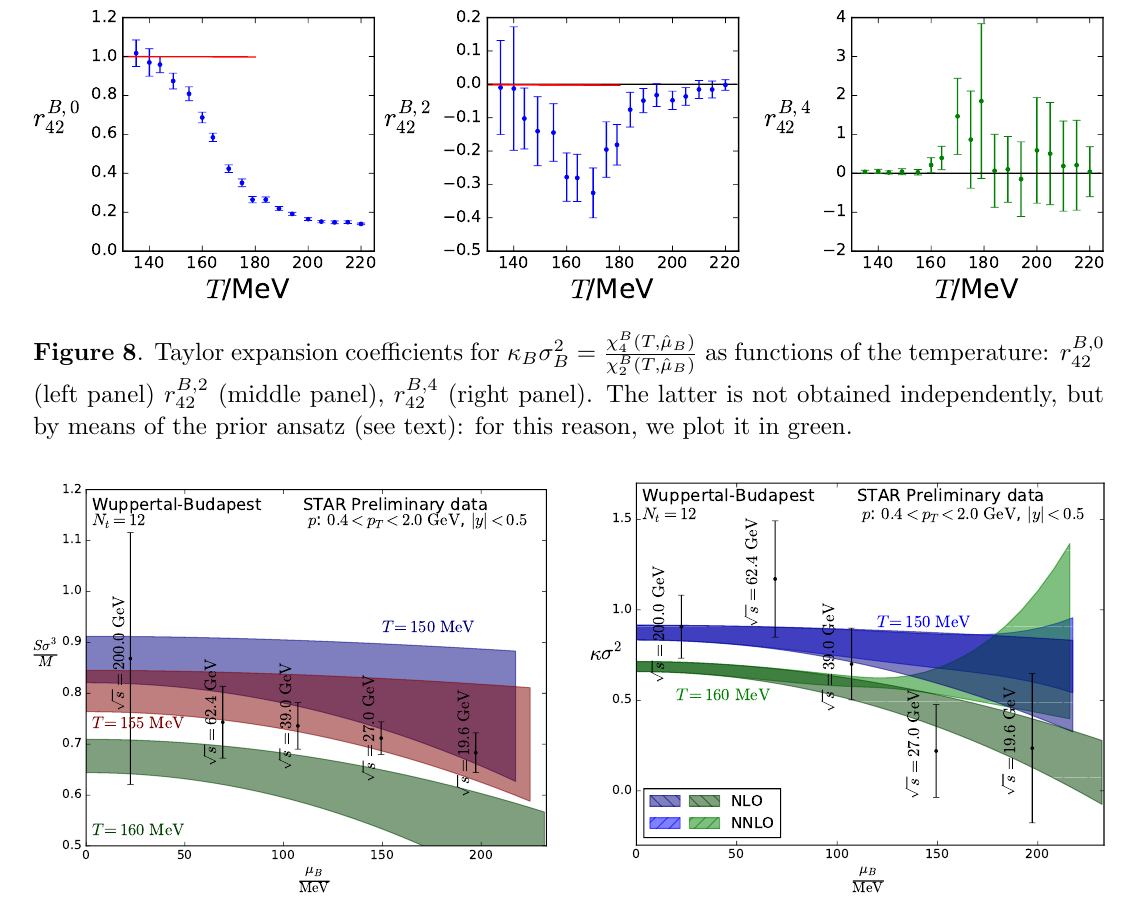
Figure 9 . S B (cid:27) 3 =M B (left panel) and (cid:20) B (cid:27) 2 (right panel) extrapolated to (cid:12)nite chemical potential. B B The left panel is extrapolated up to O (^ (cid:22) 2 ). In the right panel, the darker bands correspond to the B extrapolation up to O (^ (cid:22) 2 ), whereas the lighter bands also include the O (^ (cid:22) 4 B